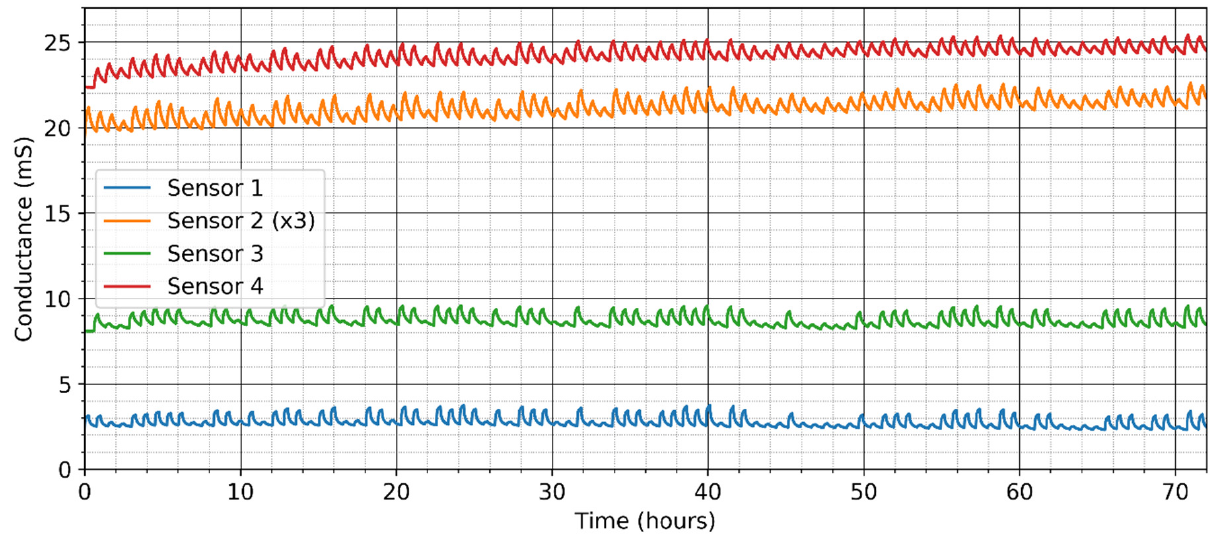
Figure 4. Responses of the four sensors to ~100 cycles of various NO 2 and O 3 combinations (30 or 60 ppb) over the course of several days. For better visibility, the signal of sensor S2 has been multiplied by factor of three. Table 2. Sensitivities of the sensors to the individual gases at 30 ppb concentration (average over all cycles, uncertainties indicated in the brackets as double standard deviation).